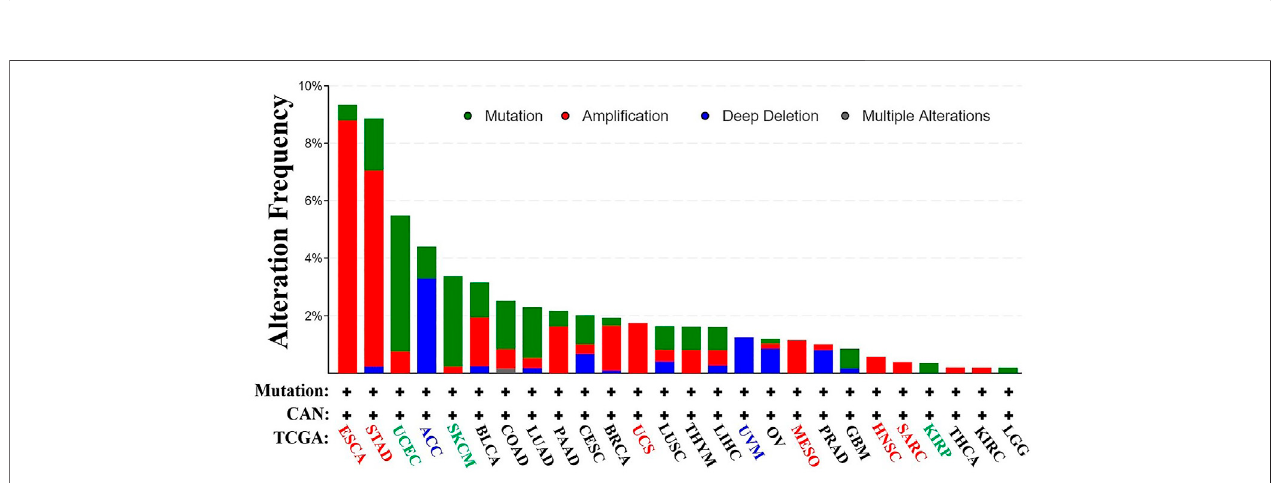
FIGURE5| Alteration frequencyofKRT17inavariety ofmalignancies.The fi gure showed thatKRT17wasthemaintype ofampli fi cation inesophagealcancer,the main type of mutation in UCEC, and the main type of deep deletion in ACC (TCGA dataset).